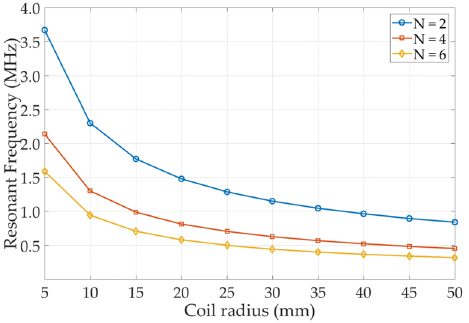
Figure 10. Resonant frequency variation with coil radius and the number of turns.